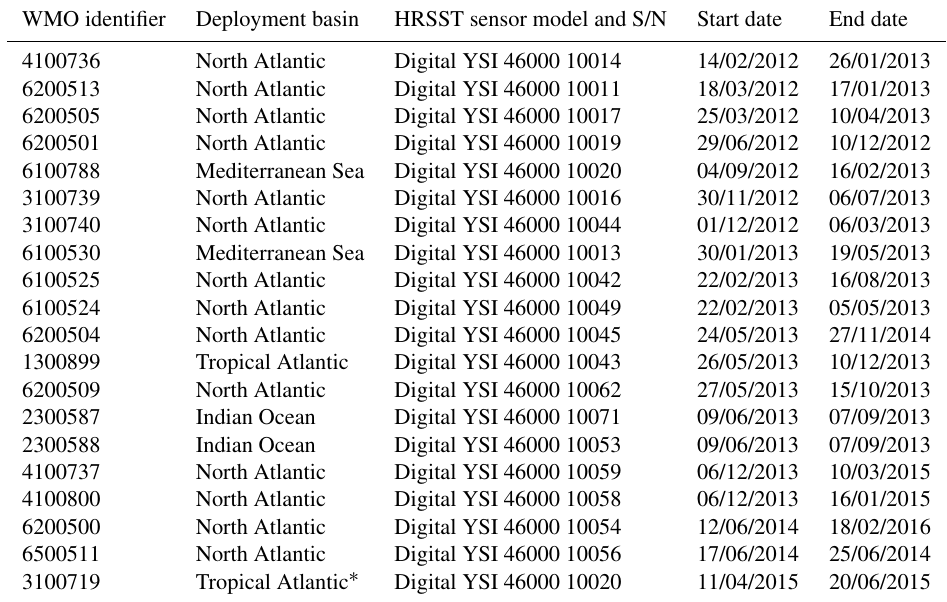
Table 2. Similar to Table 1 but for HRSST-2 SVP-BS buoys (each buoy was also fitted with a CT